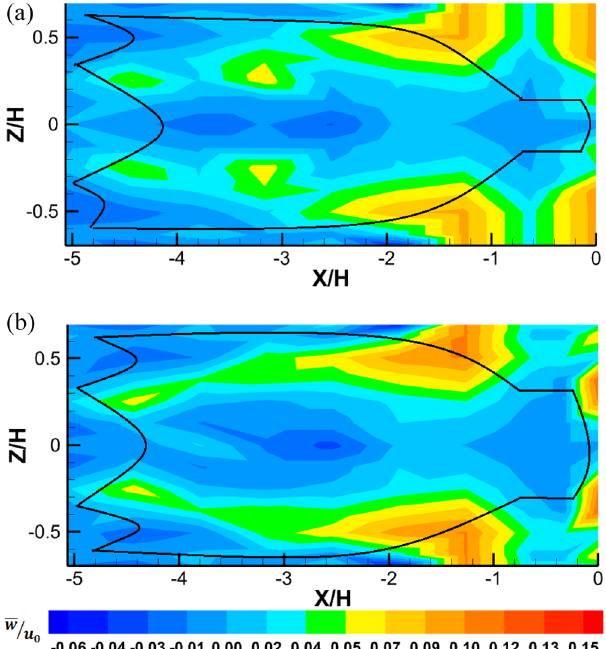
Figure 6. Mean transverse flow velocity ( w / u 0 ) develops inside and around midwater trawl net ( a ) Trawl without catch and ( b ) Trawl with catch at the front